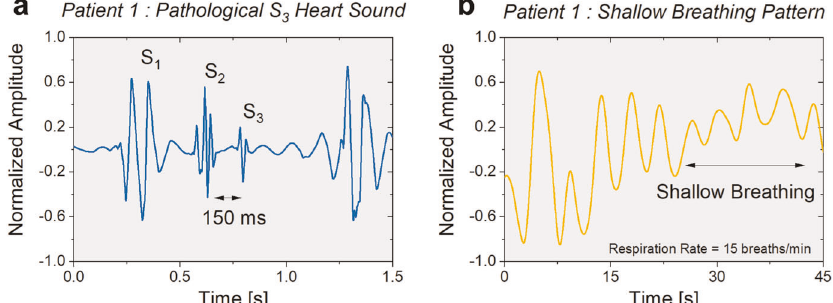
Fig. 4 Validating detection of weak mechano-acoustic signals. a Time domain plot of measured cardiac sounds. Presence of abnormal ventricular gallop (S 3 ) occurring 150 ms after S 2 heart sound. b Breathing pattern monitored by the ACM shows instances of shallow breathing indicating shortness of breath. Respiratory rate of 15 breaths per minute is calculated based on periodicity of the